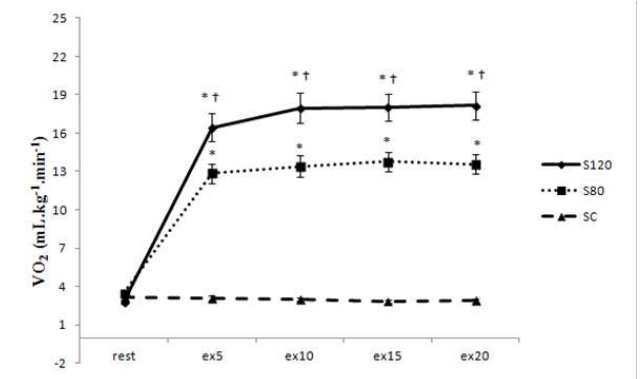
Figure 1. Mean values of oxygen uptake (VO ) during exercise in 2 S120, S80 and CON (n=11). ex5-ex20: 5min to 20min of exercise. S120= exercise session at 120% of lactate threshold; S80= exercise session at 80% of lactate threshold; CON= control session. *= p <0.05 in relation to CON; †= p <0.05 in relation to